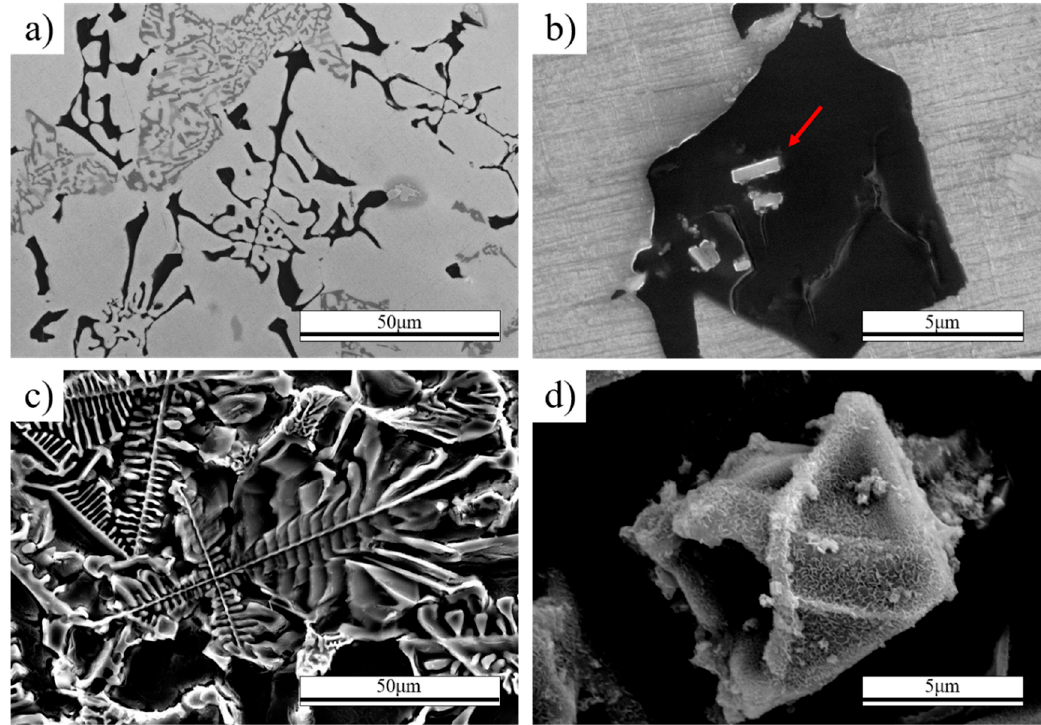
Figure 6. Microstructure of the eutectic Mg 2 Si phases; ( a ) no modification; ( b ) modification; ( c ) no modification after deep etching; ( d ) modification after deep etching.